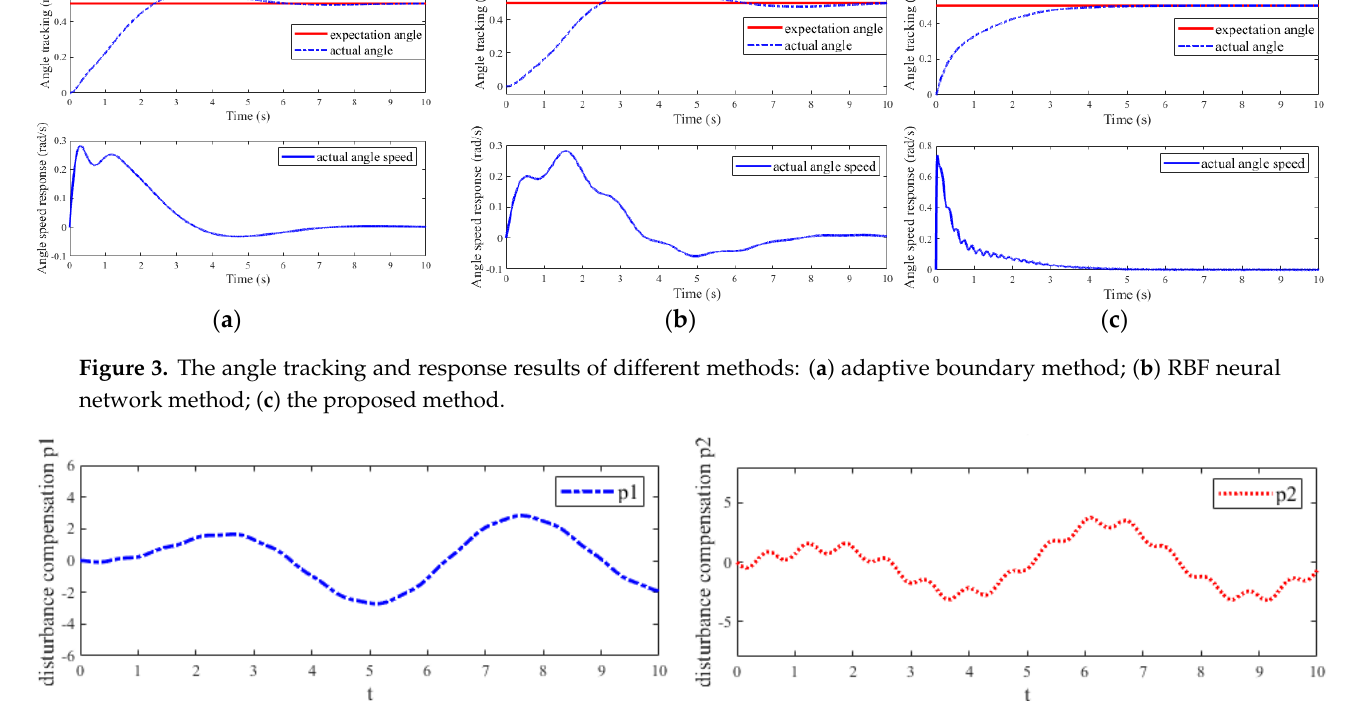
1 ; ( b ) compensation results of p 2